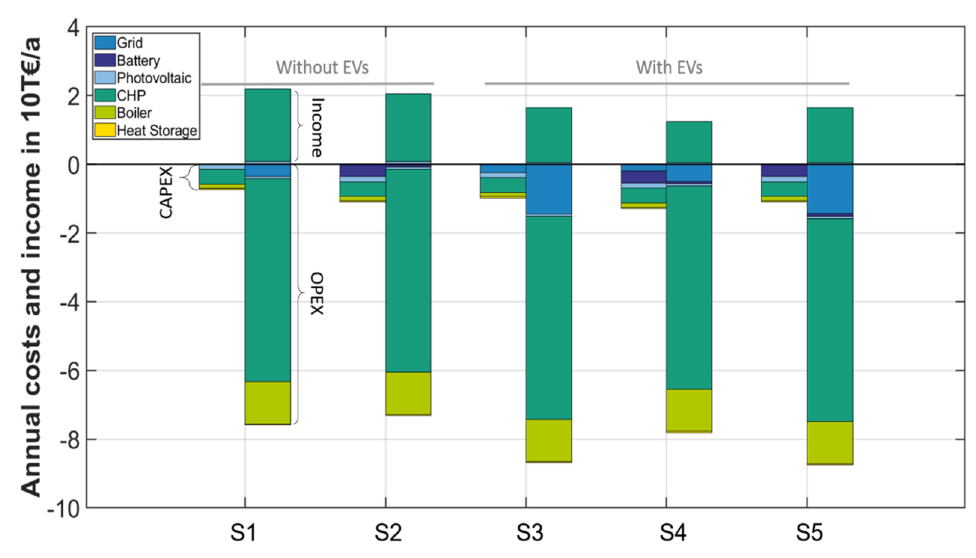
Figure 7. Overview of investment costs (CapEx), operating costs (OpEx) and incomes of the four system scenarios without electric vehicles (S1–S2) and with 30 electric vehicles (S3–S5).